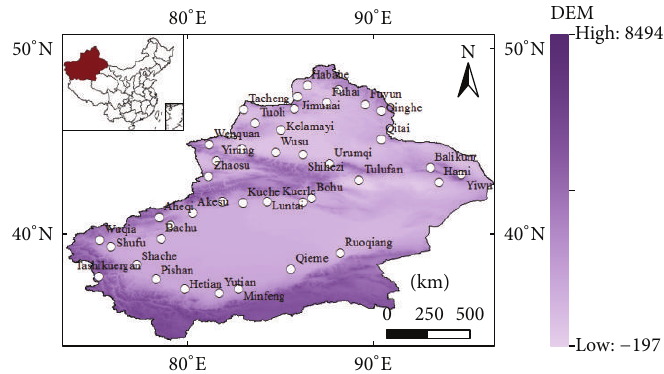
Figure 1: Digital elevation model (DEM) showing the geological location of the weather stations used in this study.